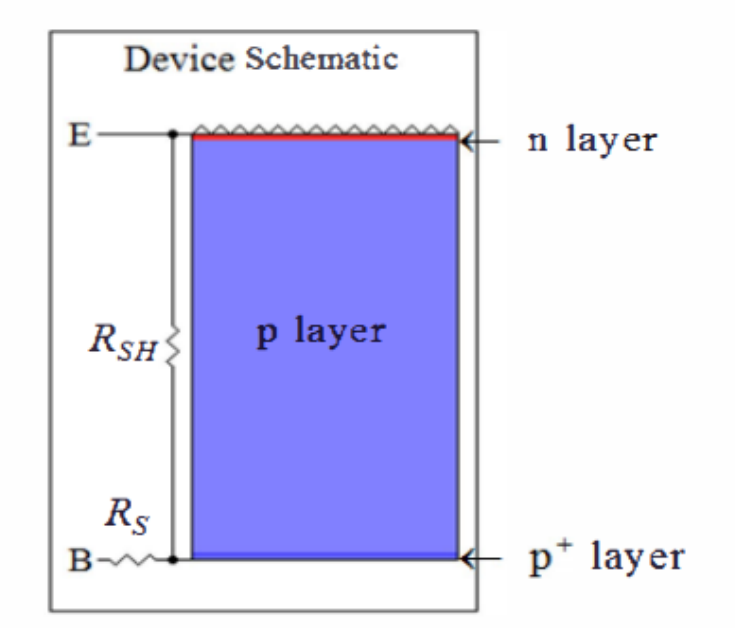
Figure 1. Schematic of the solar cell